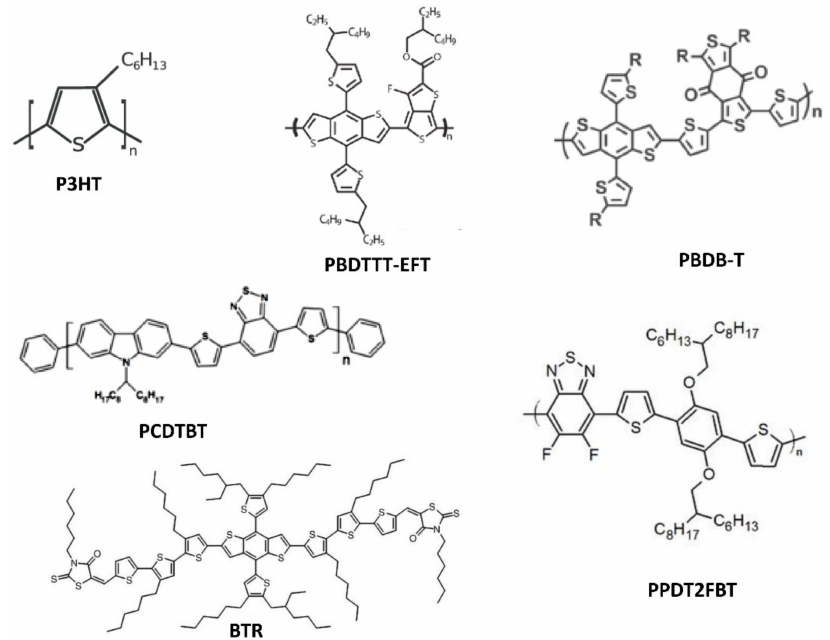
Figure 9. Chemical structures of various widely used organic semiconducting donor materials for